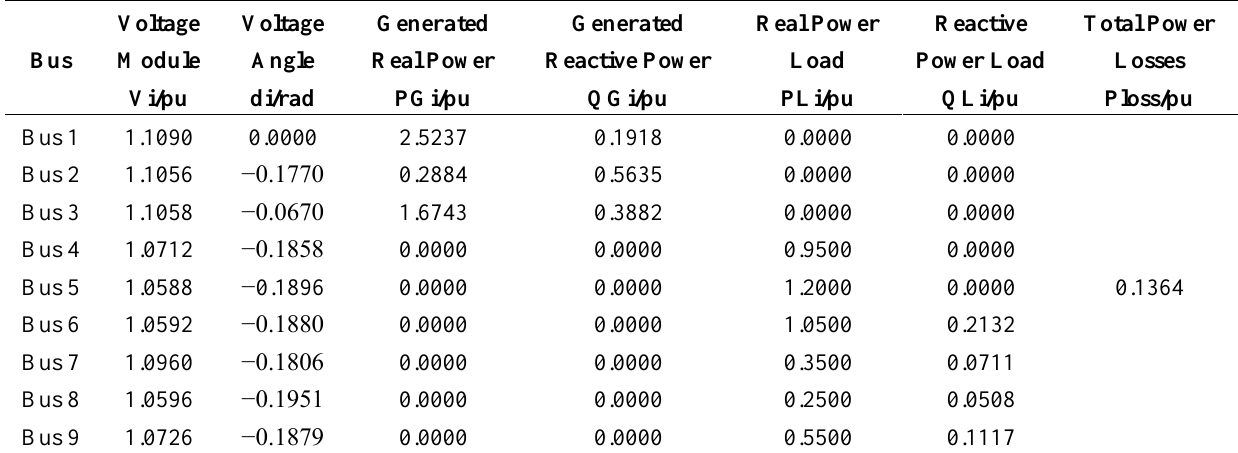
Table 6. Initial operating